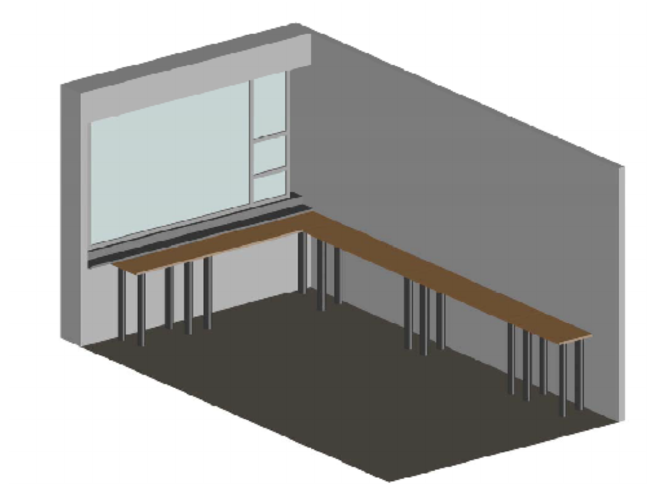
Figure 1. Measurement